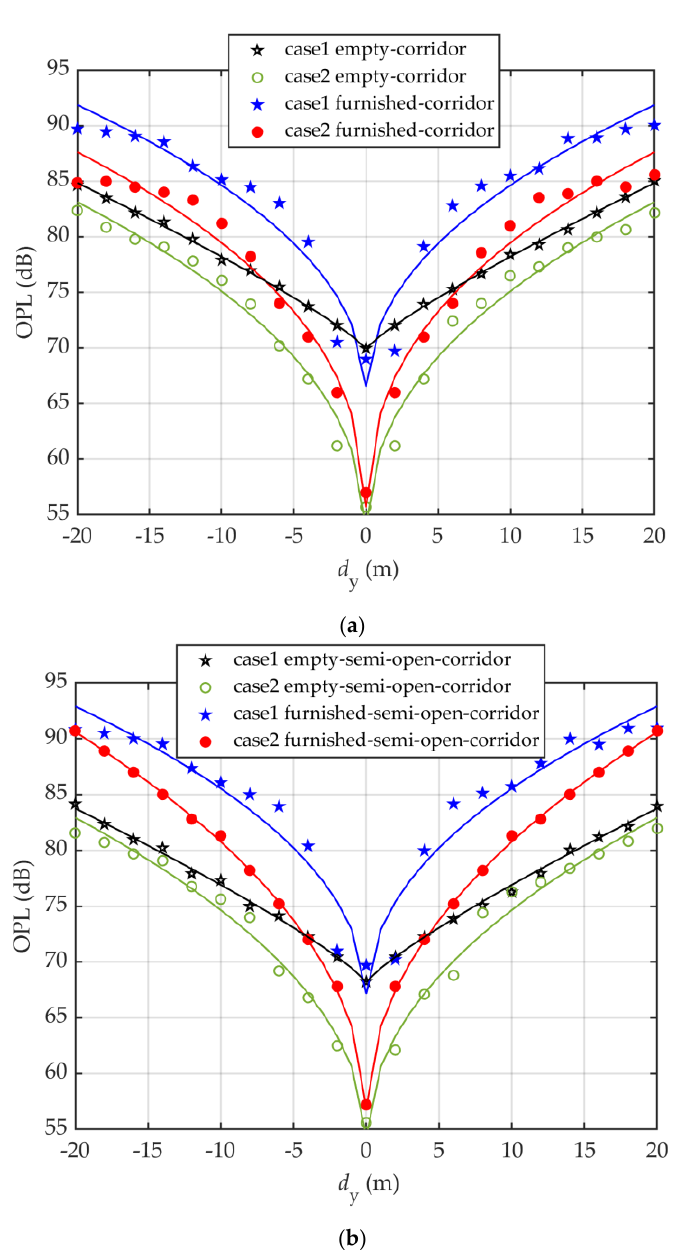
Figure 10. Channel characteristics in term of OPL for both: ( a ) corridor, and ( b ) semi-open corridor environment; when OLED are mounted on the inner shop wall behind the glass window (case1) and on the wall or shop window inside the corridor (case2) while the user is moving along the corridor.